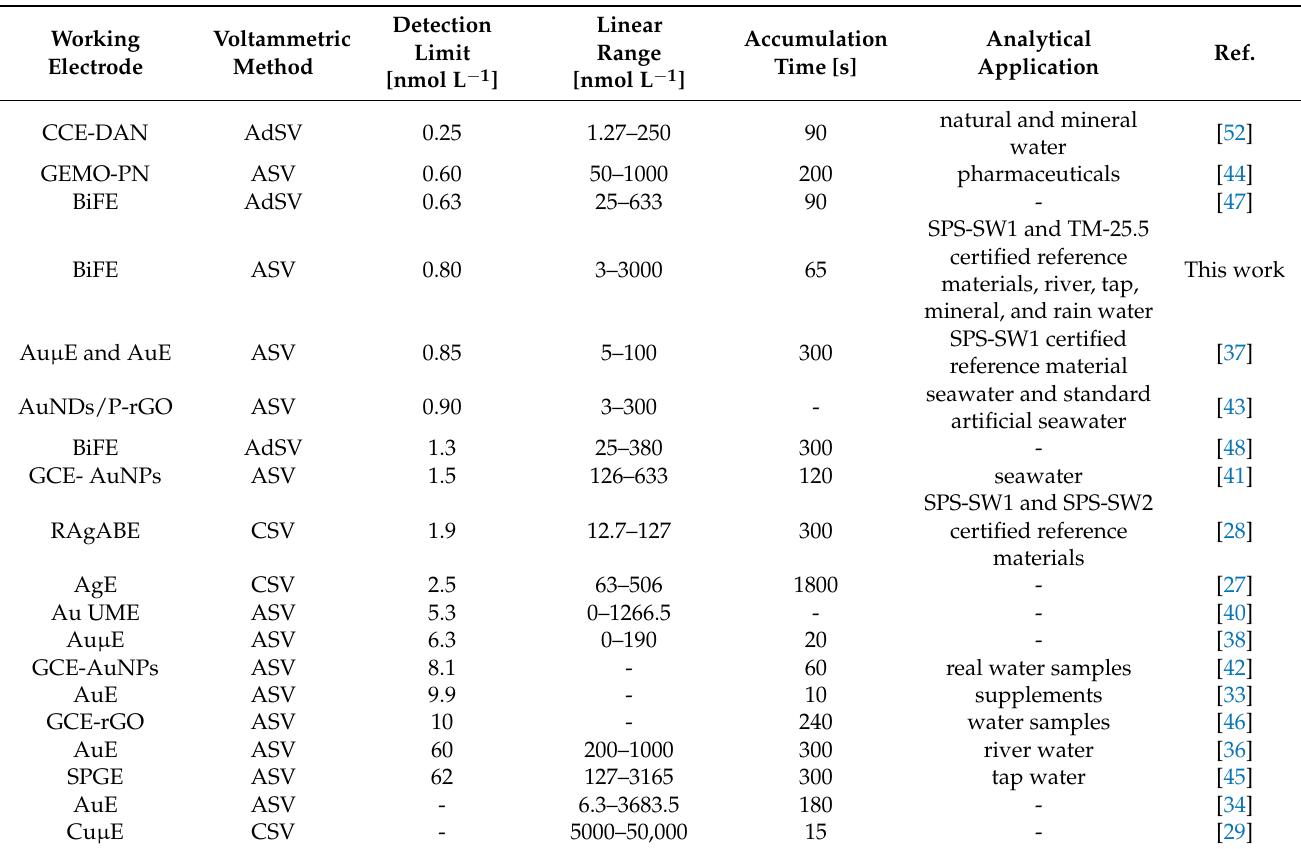
Table 1. Comparison of parameters of the proposed procedure with other stripping voltammetric procedures using ecofriendly mercury free working electrode for trace Se(IV) determination. The procedures are arranged according to the growing detection